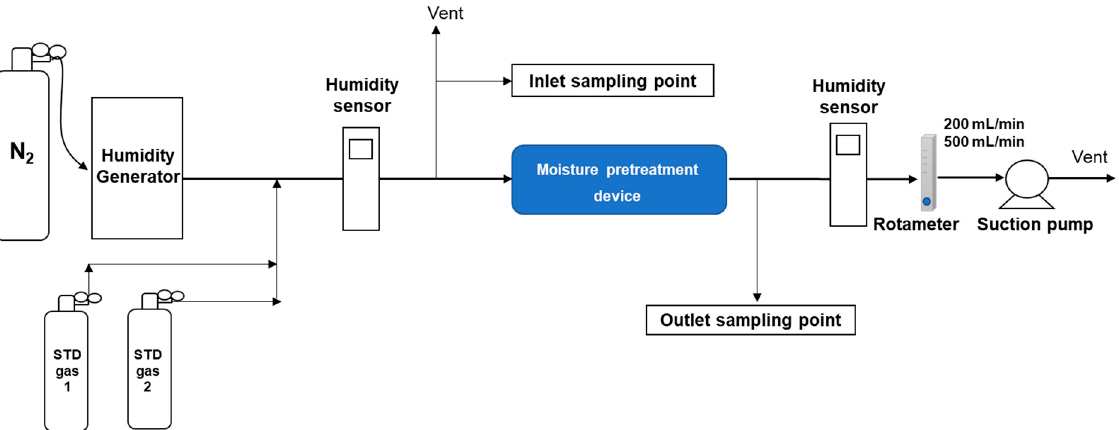
Figure 2. Sampling train for comparing gas recovery rates associated with a moisture pretreatment system.